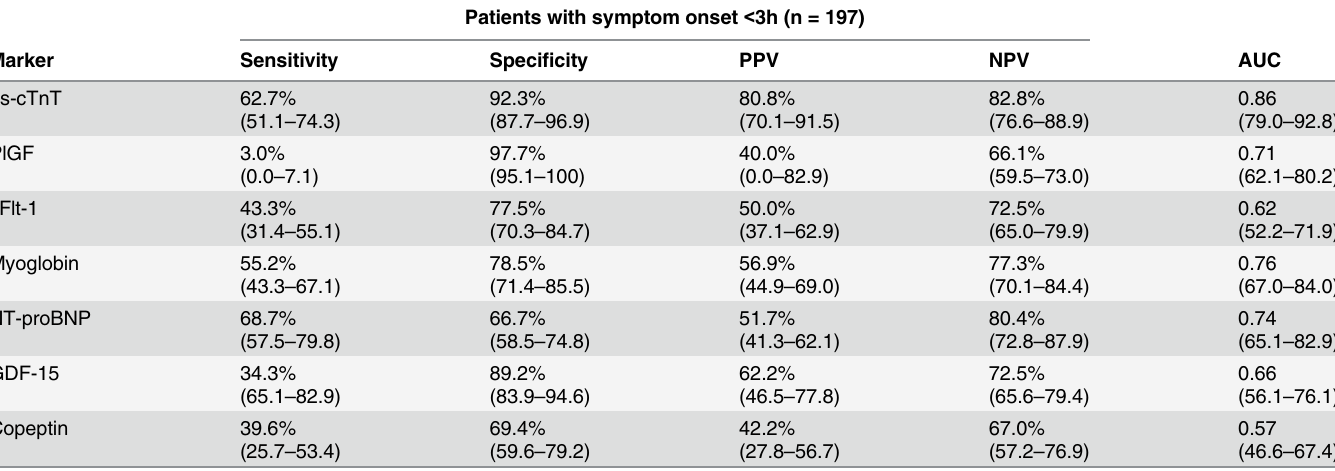
Table 4. Sensitivity, specificity, predictive values and AUCs of hs-cTnT, myoglobin and 5 novel biomarkers in patients with symptom onset within 3